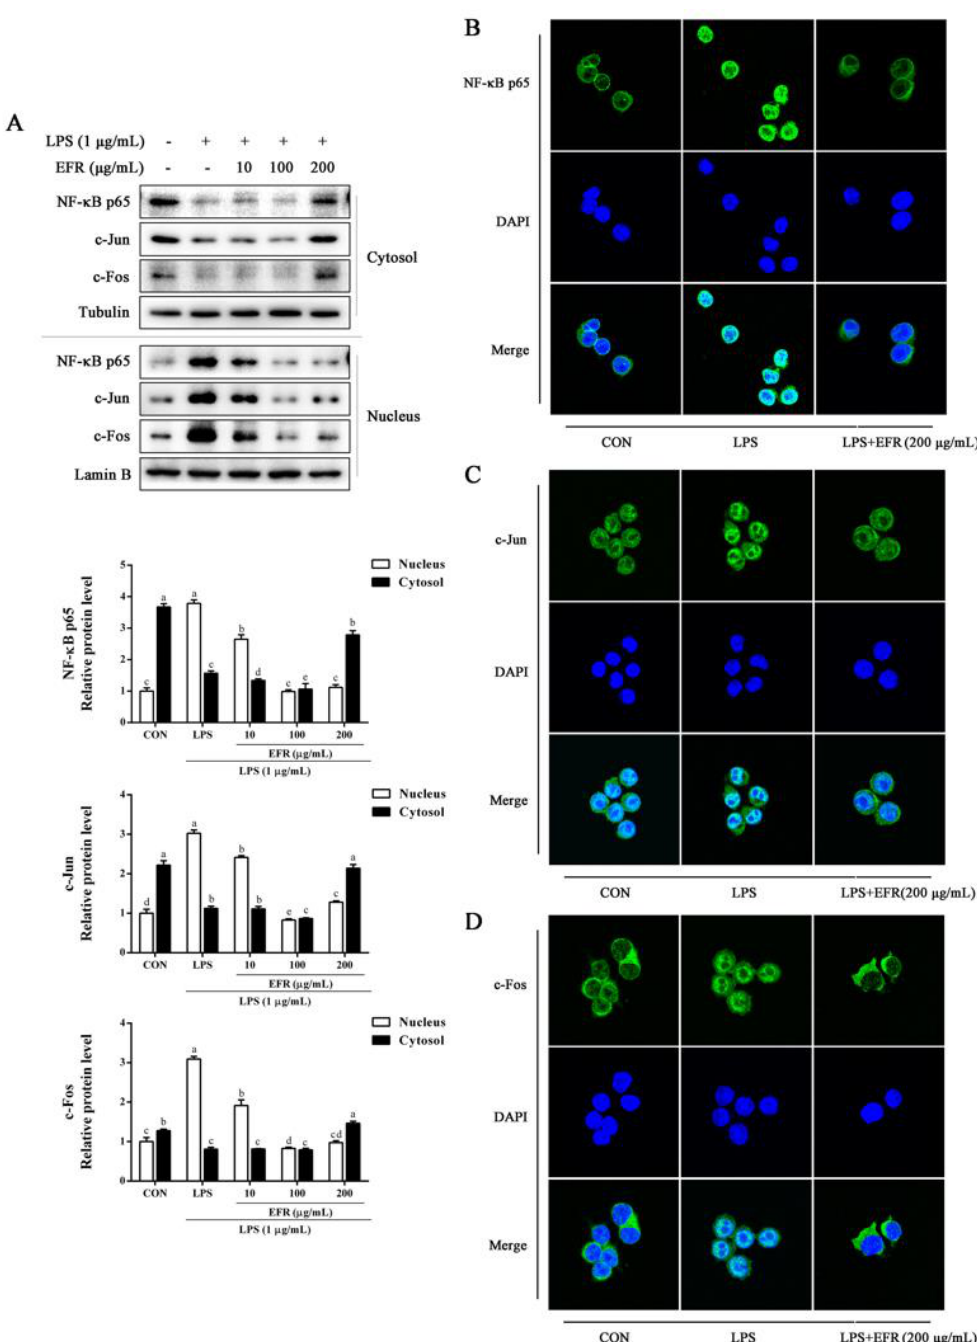
Figure 3. Effect of EFR on LPS-induced NF- κB p65 and AP -1 nuclear translocation in RAW 264.7 macrophages. ( A ) RAW 264.7 macrophages were pretreated with EFR (10, 100, and 200 μg/mL) for 2 h and then stimulated with or without LPS (1 μg/mL) for 30 min. The nuclear an d cytosolic extracts of cells were prepared, and the protein levels of NF- κB p65, c -Jun, and c-Fos were determined by Western blot analysis. Lamin B and Tubulin were used as endogenous controls for the nucleus and cytoplasm, respectively. Relative intensity of the immunoreactive bands was analyzed using the Image J software. RAW 264.7 macrophages were pretreated with EFR (200 μg/mL) for 2 h and then stimulated with or without LPS (1 μg/mL) for 30 min. The cellular localization of NF - κB p65 ( B ), c-Jun ( C ), and c-Fos ( D ) was determined by immunofluorescence assay. Results are shown as the mean ± SD of three independent experiments. The different letters represent the statistical differences at p < 0.05 among the groups by Duncan ’ s multiple range test.